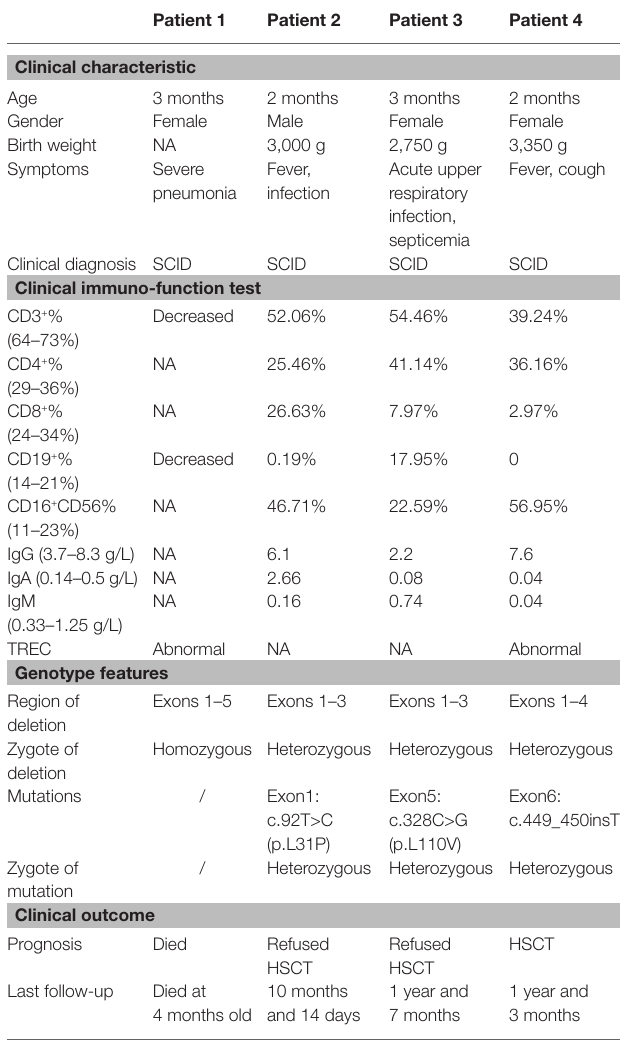
TABLE 1 | Clinical characteristics of the included four